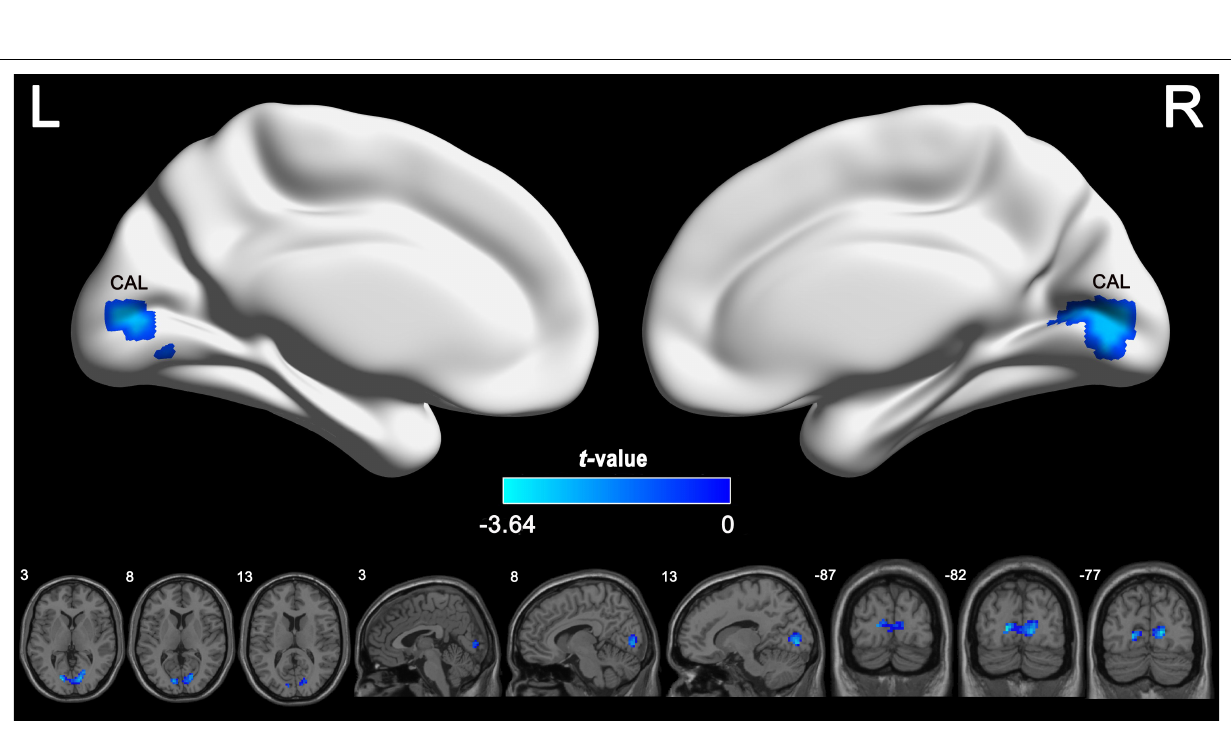
Frontiers in Neuroscience |